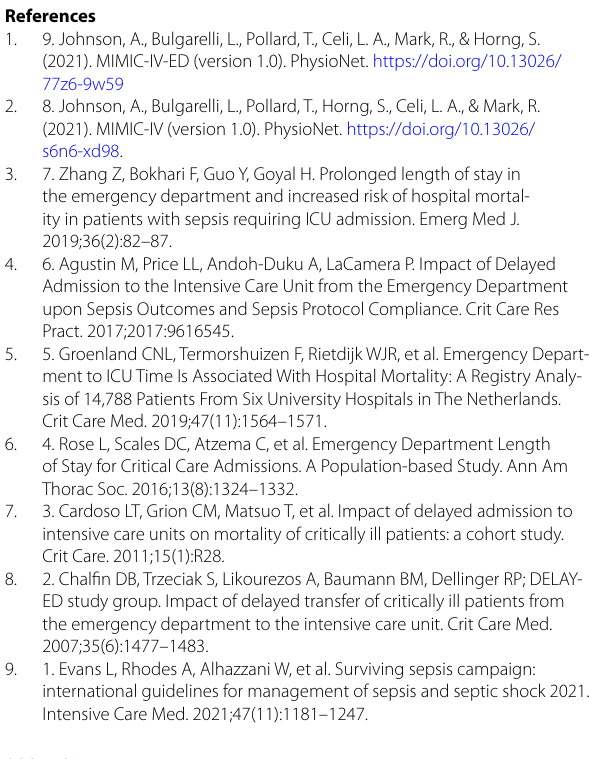
Conclusion: Earlier admission to the ICU (e.g., within 3.3 h of ED visits) was associated with lower 28-day mortality in patients with sepsis. Our findings suggest that adult patients with sepsis who require intensive care should be admitted to the ICU within 3